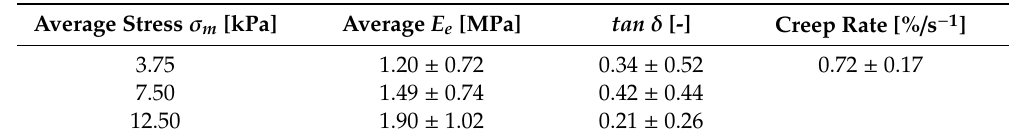
Figure 4. Spread of elastic, E e , and loss modulus, E l , data of bovine tissue from various ovaries. Figure 5. Elastic and viscous properties of ovarian tissue at different average stress σ m : ( a ) storage modulus ( E e ); ( b ) loss tangent ( tan δ ). Table 1. Mechanical properties of cortical ovarian tissue.